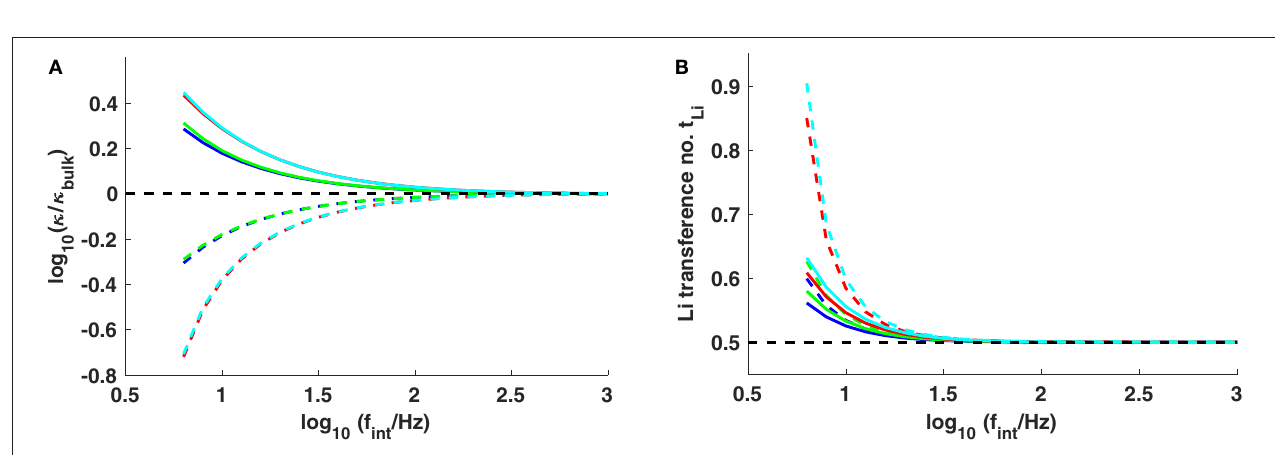
FIGURE 4 | Distributions of (A) potential 8 , (B) cation particle fraction (solid line: y + , dotted line: y Li ), (C) pressure p , (D) local conductivity κ , and (E) local lithium transference number in a 10 µ m Li 0.5 bmim 0.5 BF 4 slab sandwiched between two reactive electrodes under a potential bias of 20 mV. Interfacial frequencies are 20 kHz (blue), 1 kHz (red), and 0 Hz (green).